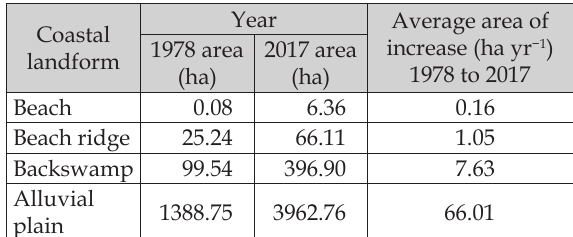
Table 4. Settlements and average area comparisons for coastal landforms for 1978 and 2017 in the study